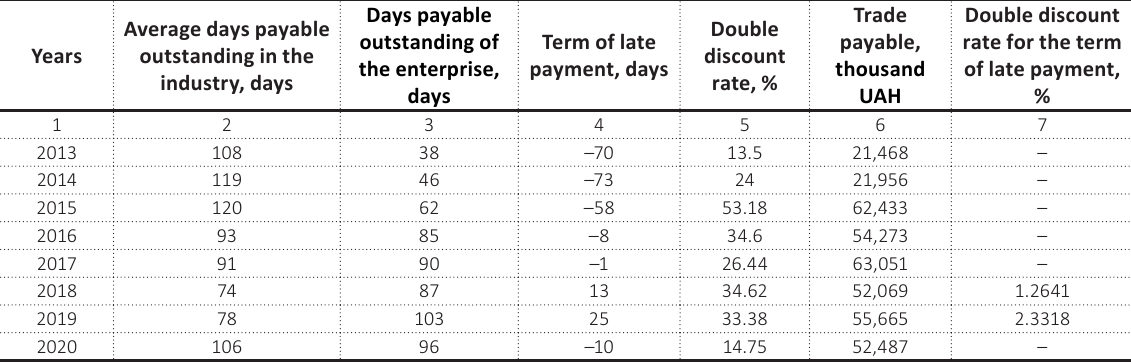
Table 5. Constants for determining the cost of trade payable in the dairy industry